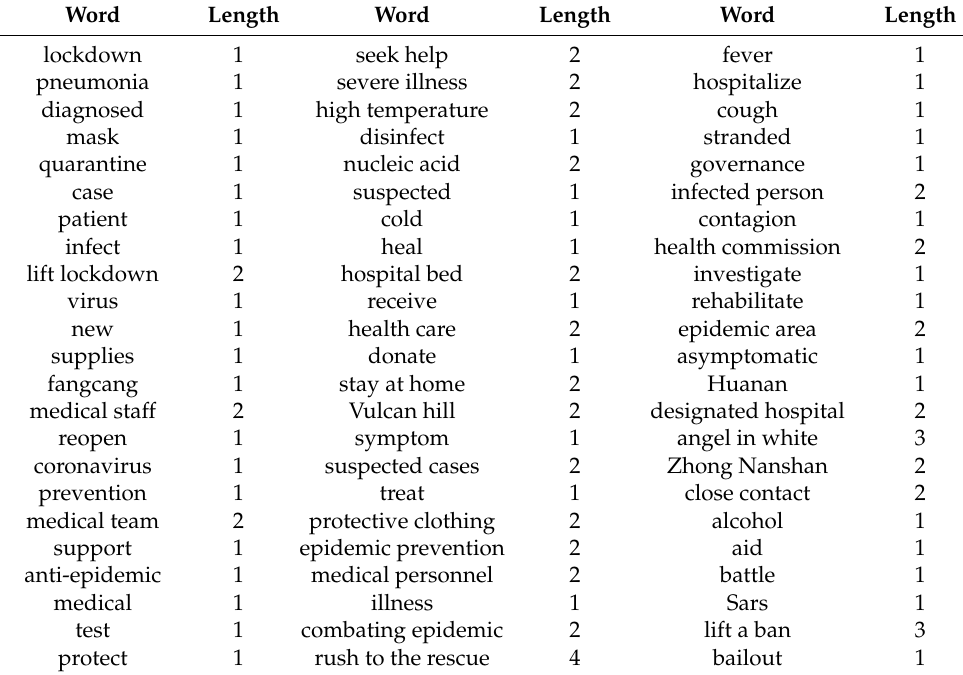
Table 1. Summary of high-frequency words related to the COVID-19 epidemic.